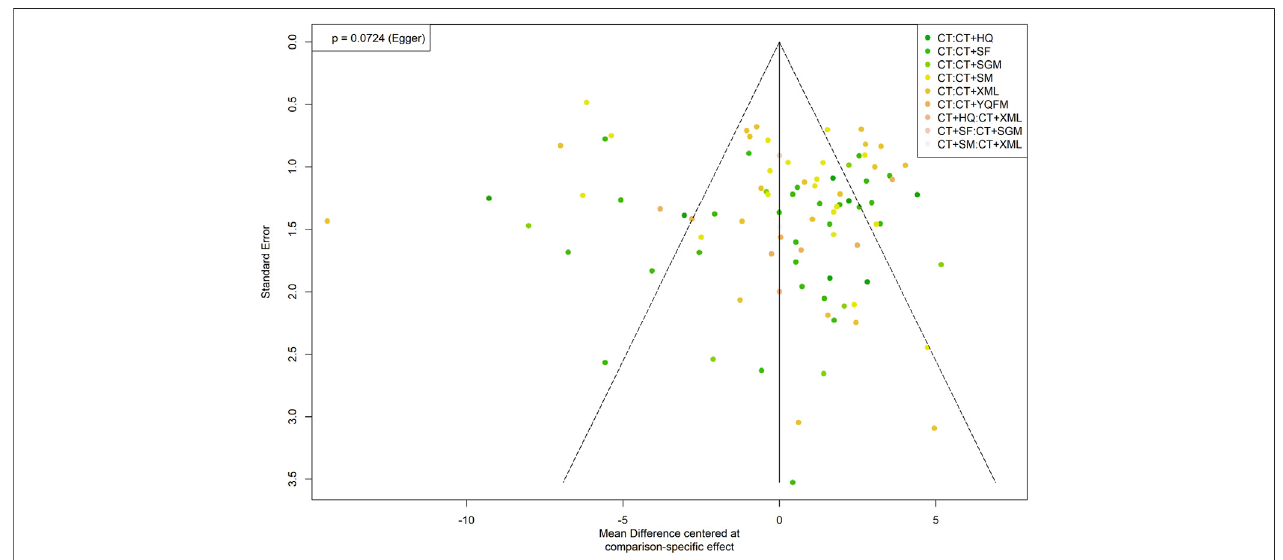
FIGURE 6 | Funnel plot of left ventricular ejection fraction. CT, conventional treatment; HQ, Huangqi injection; SF, Shenfu injection; SGM, Shengmai injection; SM, Shenmai injection; XML, Xinmailong injection; YQFM, Yiqifumai lyophilized injection.